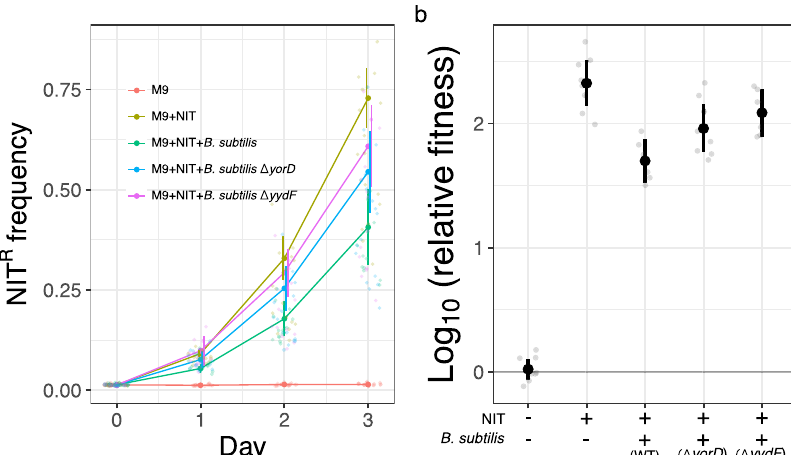
Fig. 6 Deletion of yydF gene from B. subtilis 168 offsets dampening of NIT resistance enrichment. a Lines depict increases in frequencies of NIT R cells over 3 days at sub-MIC. Colors depict dynamics during interspecies interactions with different B. subtilis strains. The wild-type strain used here is the parent strain of Δ yydF and Δ yorD ordered from BGSC (see “ Methods ” ). b Depiction of differences in log-transformed relative fi tness of NIT R cells after 3 days of competition with NIT S cells in the presence of B. subtilis strains deleted for or carrying functional copies of either yydF or yorD genes. The log-transformed relative fi tness value of zero (gray horizontal line) represents no fi tness advantage to either NIT R or NIT S strains, while positive values indicate an advantage to NIT R strains. All competitions were conducted in M9-Glucose with or without NIT, as mentioned in the legends ( a ) or on the x axis ( b ). Lighter points depict individual replicates, darker points represent means and error bars represent 95% con fi dence intervals ( t -distribution, n = 8 for both